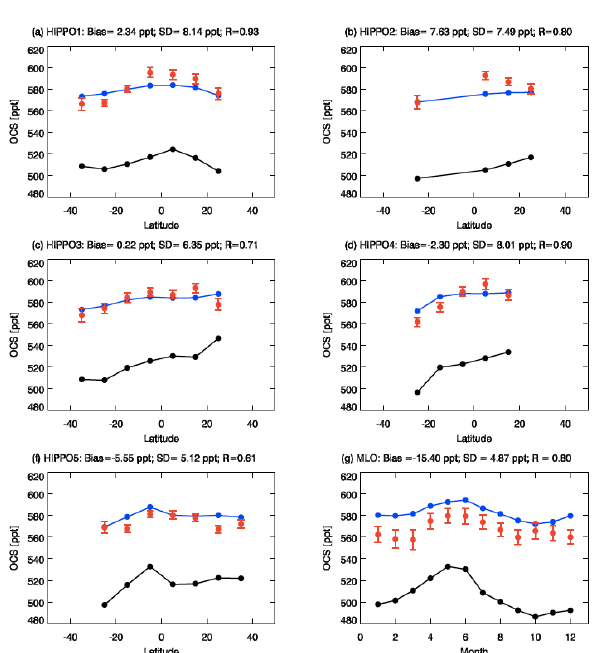
Fig. 8. Individual comparison between TES multi-­‐year monthly means and in situ data for latitudinal patterns (a － f) and seasonal variations (g). Original in situ data averaged over latitude bins in black; in situ data applied with TES operator in blue; TES data in red. Bias, standard deviation (SD) and correlations (R) for the comparison between blue and red are given. Error bar represents the error on the mean (standard variation within the grid bin divided by the square root of the number of observations).